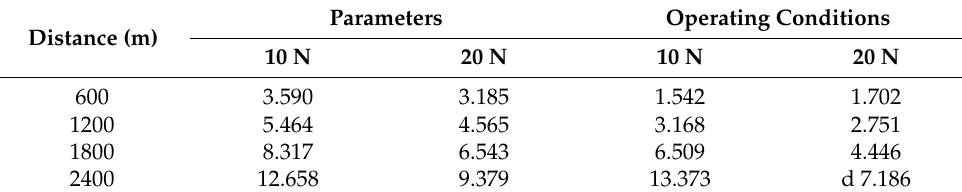
Table 3. The wear coefficient K (10 4 mm 3 /N.m.) when compared with substrate material. Parameters Distance (m)